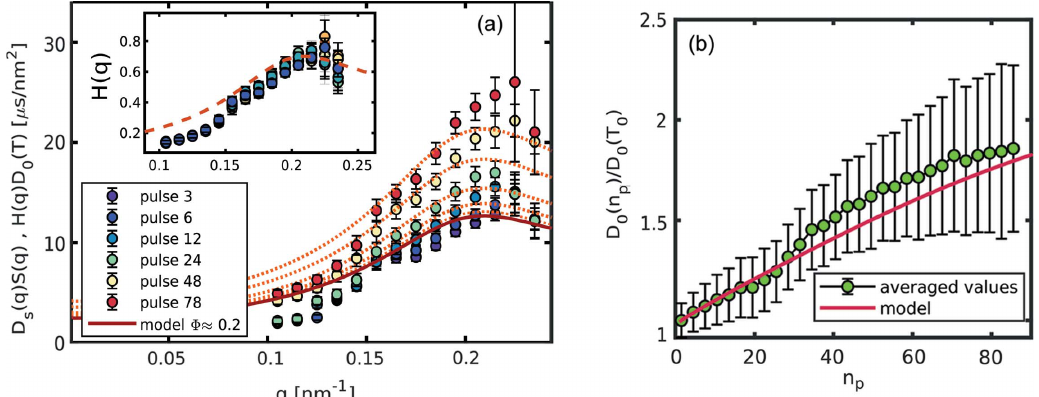
Figure 5 Dynamical quantities as a function of the number of pulses for sample A exposed to 10.5 mJ mm (cid:2) 2 . ( a ) Contribution of the HIs to the diffusion constant for various n p . The lines are the equilibrium H m ( q ) multiplied by the expected diffusion constant. In the inset the data points are rescaled by the expected diffusion constant and plotted together with the equilibrium H m ( q ). ( b ) Relative change in the diffusion constant; the values are obtained from the Þ = (cid:3) ð q ; n ¼ 1 Þ , and the error bars from the propagation of the uncertainty of the fitted relaxation rates, expressing a systematic average over q of (cid:3) ð q ; n p p error originating from a reduced time resolution at larger n p . The red line is the change in D 0 ( T ) as expected from the time-resolved model by Lehmku¨hler et al.